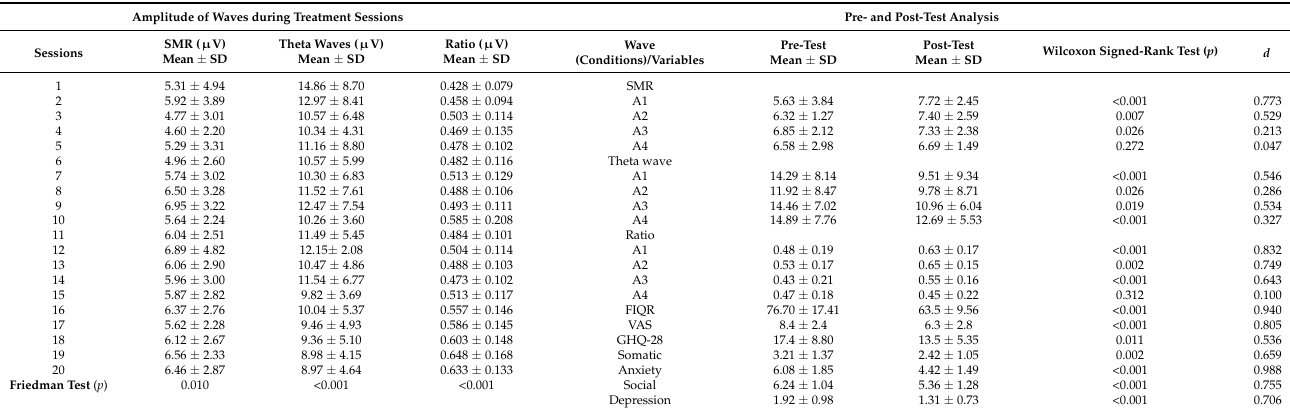
Table 2. Amplitude of waves during treatment sessions and pre- and post-test